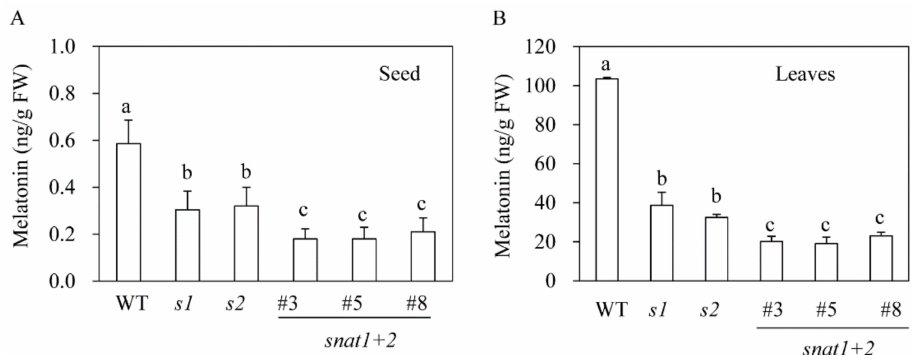
Figure 3. Melatonin content of seeds and leaves. ( A ) Melatonin content of seeds. ( B ) Melatonin content of rice leaves upon cadmium treatment. Seeds imbibed water for 9 h and were then subjected to high-performance liquid chromatography (HPLC) analysis for melatonin quantification. Seven-day-old rice seedlings were rhizospherically challenged with 500 µ M CdCl 2 for three days to induce melatonin production, and leaves were subjected to melatonin analysis.